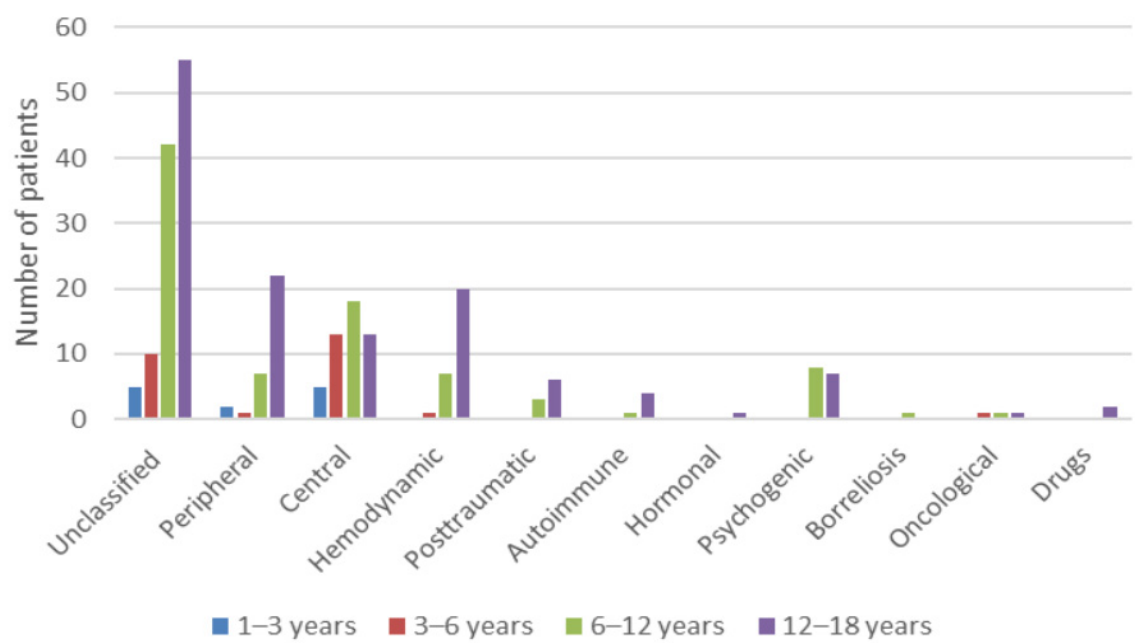
Figure 5. Age distribution stratified by the etiology of pediatric vertigo and dizziness. There were several different pathologies involved in a definite diagnosis of central loss, as shown in Figure 6. Figure 7 shows the duration of vertigo and dizziness stratified by its etiology.